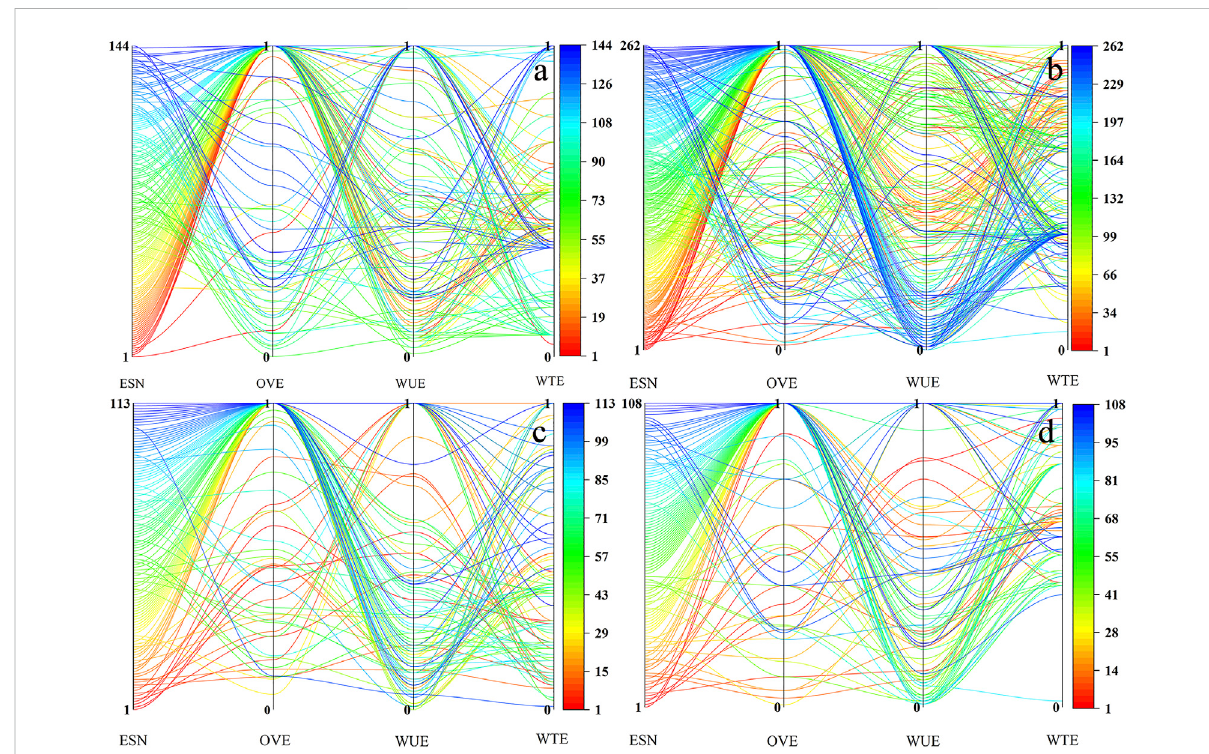
FIGURE 6 Analysis of the industrial output value ef fi ciency, water use ef fi ciency, and water treatment ef fi ciency in Tianning (A) , Wujin (B) , Xinbei (C) , and Zhonglou districts (D) . It is important to note that each line represents an enterprise. ESN = enterprise serial number, OVE = output value ef fi ciency, WUE = water use ef fi ciency, and WTE = water treatment ef fi ciency. The enterprise codes are shown in Supplementary Appendix SA. The ordinate of ESN is the serial numbers of all enterprises, and detailed information about the enterprise serial numbers is displayed in the Supplementary Appendix SA. The ordinate of OVE, WUE, and WTE are the display of the ef fi ciency statistical results calculated by the EE – SBM – DEA